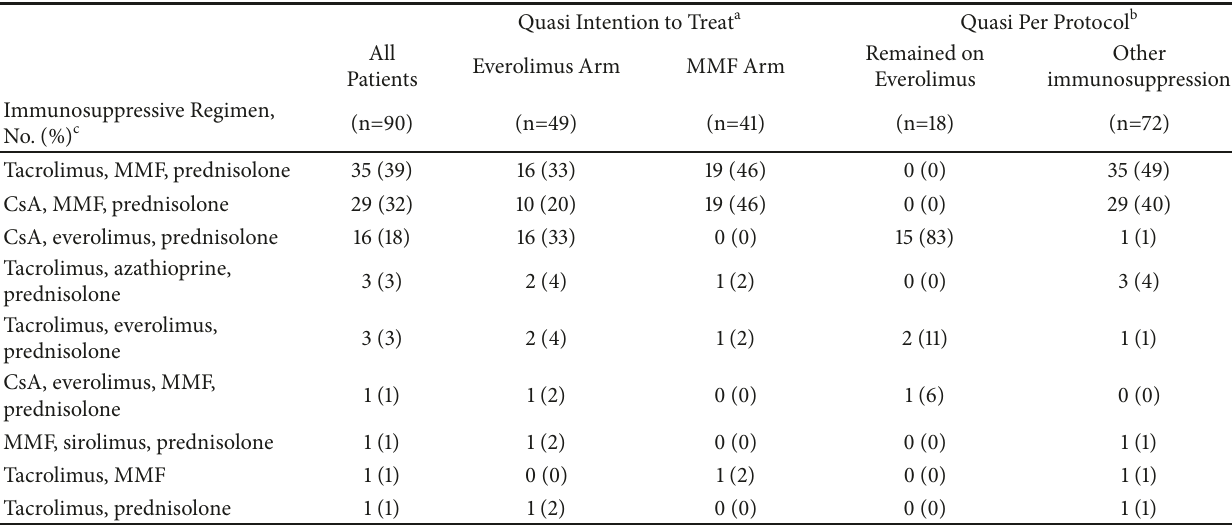
Table 2: Immunosuppressive regimens at dermatologic examination.